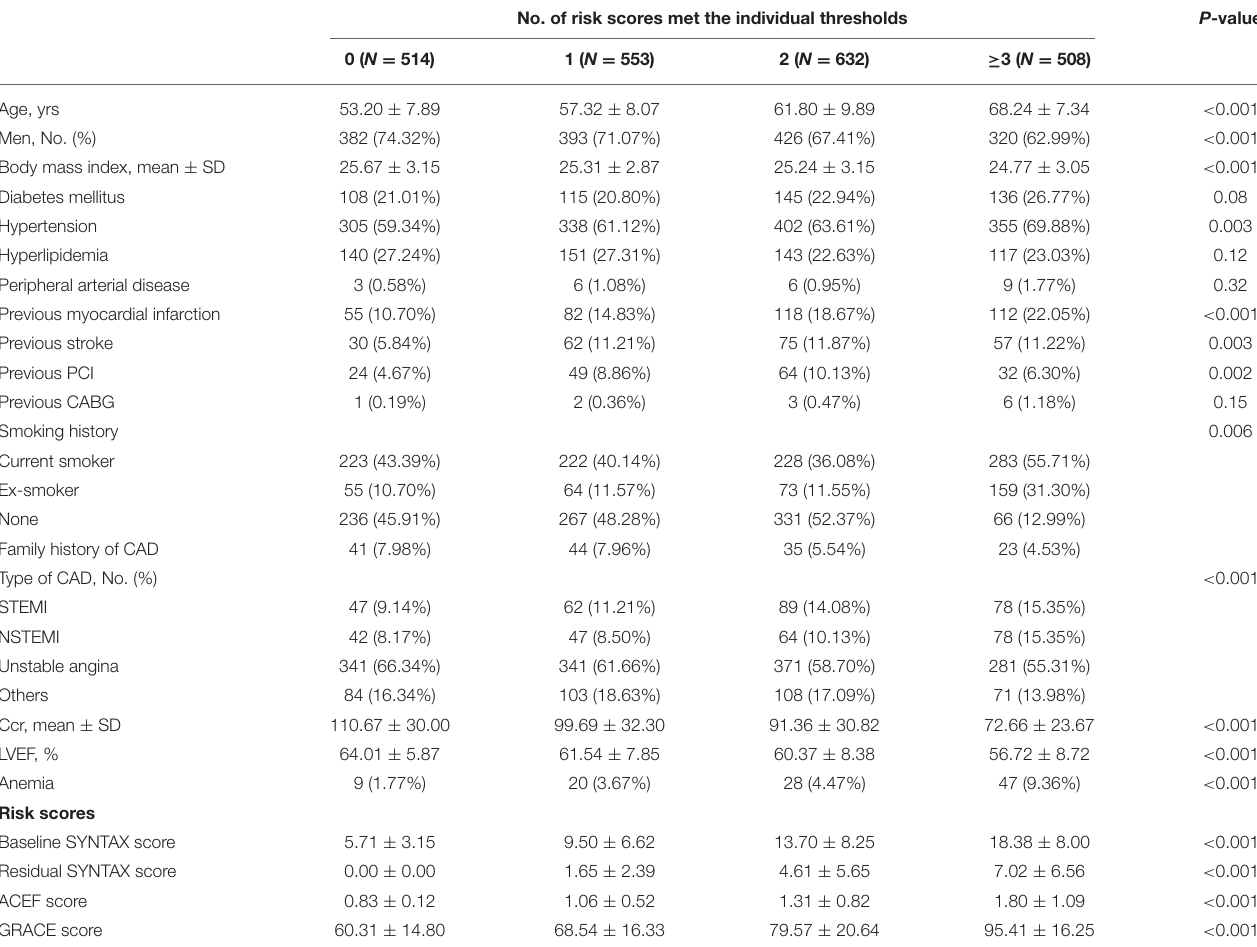
TABLE 1 | Baseline demographics and score calculation stratified across cumulative risk-score categories. No. of risk scores met the individual